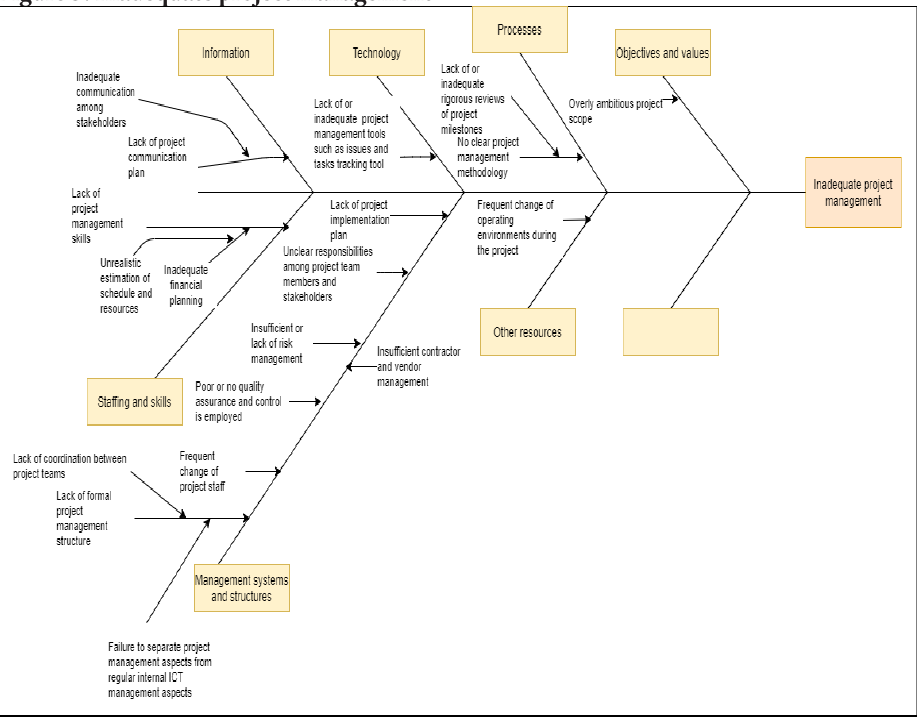
Figure 3: Inadequate project